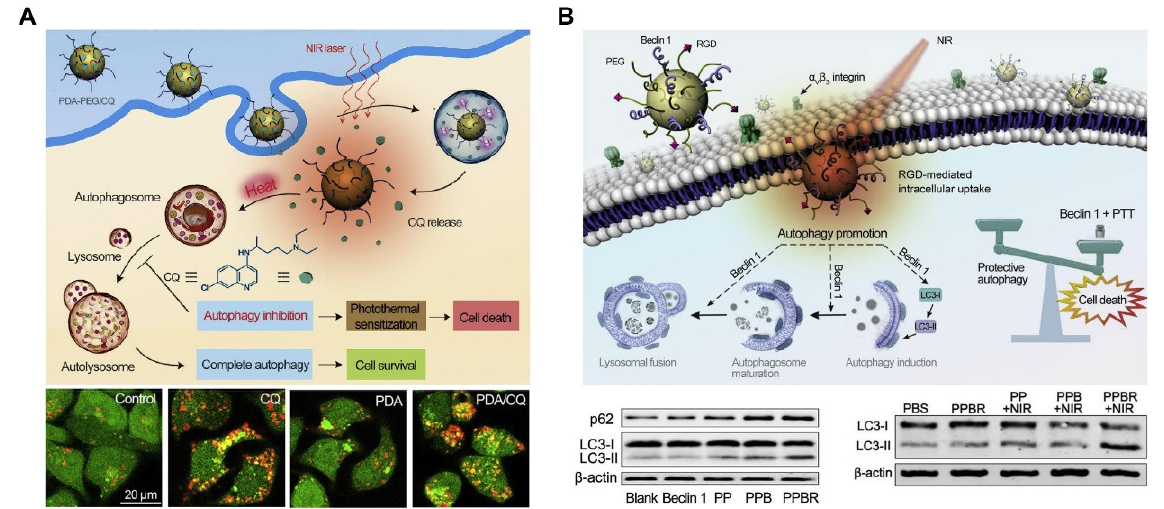
Figure 7. Two examples illustrate that autophagy sensitizes the photothermal killing of cancer cells. ( A ) Schematic of autophagy inhibition sensitizes photothermal killing of cancer cells. Western blot of LC3-I and LC3-II in HeLa cells treated with CQ and 3-MA as autophagy inhibitors, respectively [97]. Copyright © 2022, Elsevier. ( B ) The illustration depicts beclin 1-induced autophagy sensitizing photothermal killing of cancer cells. Western blot of LC3-I/LC3-II conversion and P62 in MDA-MB- 231 cells treated with beclin 1, PP, PPB, and PPBR [98]. Copyright © 2022, Elsevier.